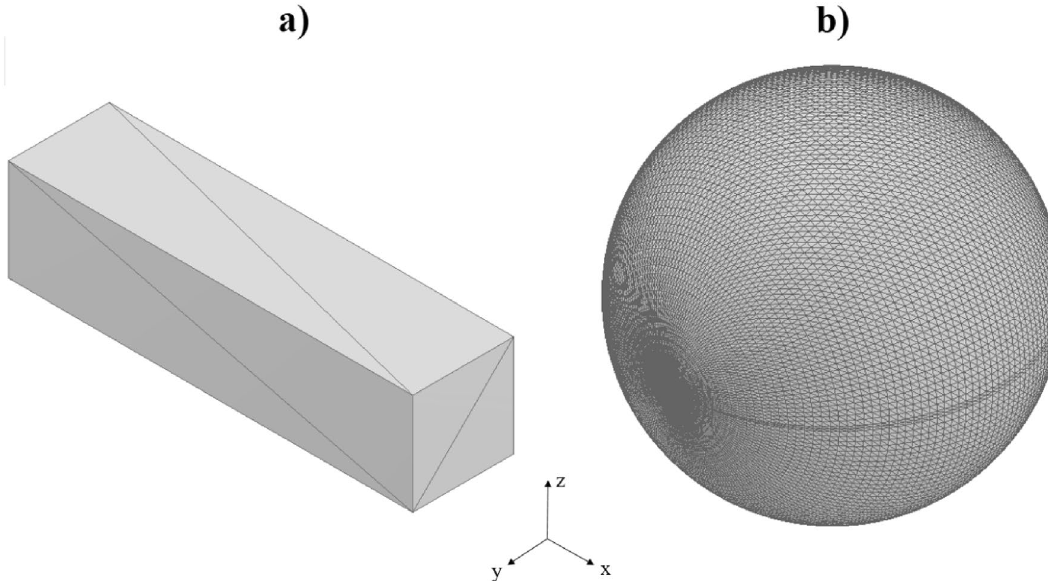
Figure 7. Convex shapes ( a ) square-based prism and ( b ) sphere.